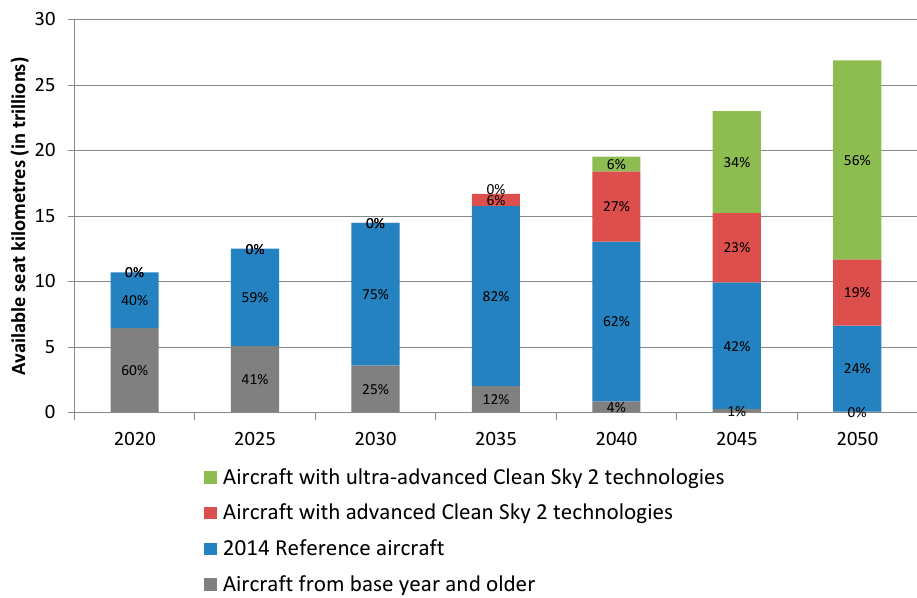
Figure 18. Available seat kilometres (ASK) by technology level in the High Scenario. The grey, blue, red and green bars add up to the total ASK volume for the respective year.